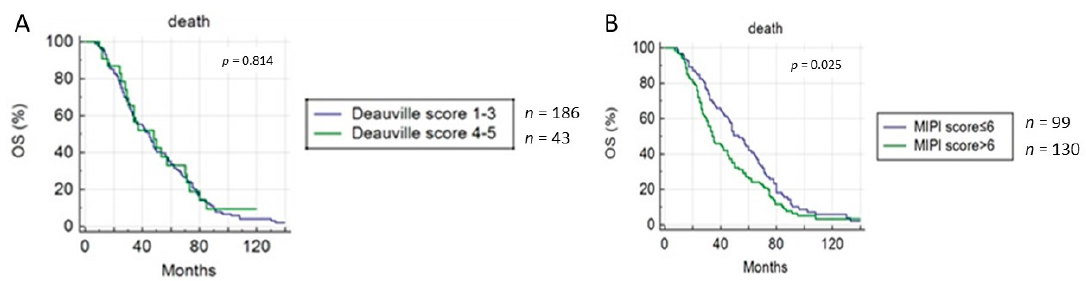
Figure 4. Progression-free survival curve combining MIPI score and Deauville score groups.